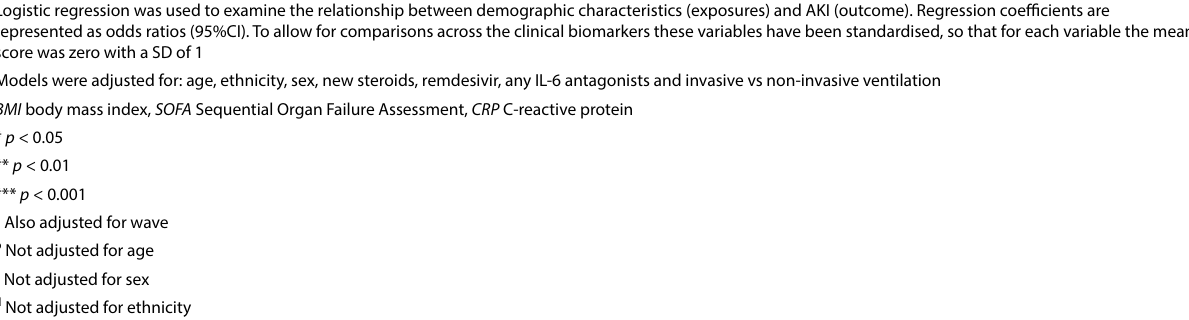
invasive MV, PEEP levels, diuretics, change in fluid bal-